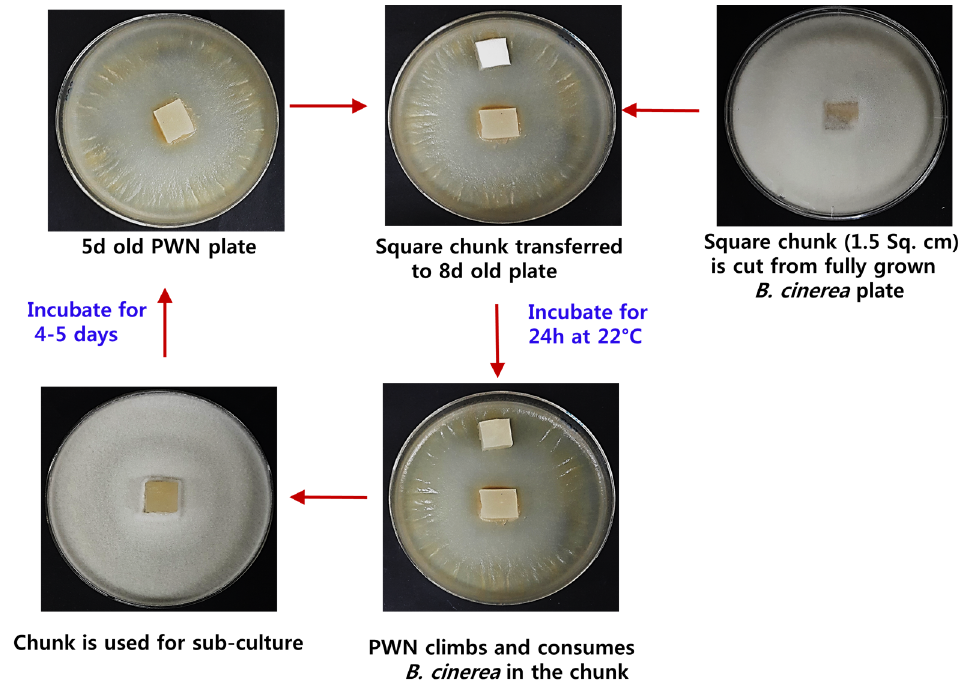
Figure 1. A simple procedure for subculturing the pinewood nematode, Bursaphelenchus xylophilus by Botrytis cinerea lawn on potato dextrose agar (PDA).